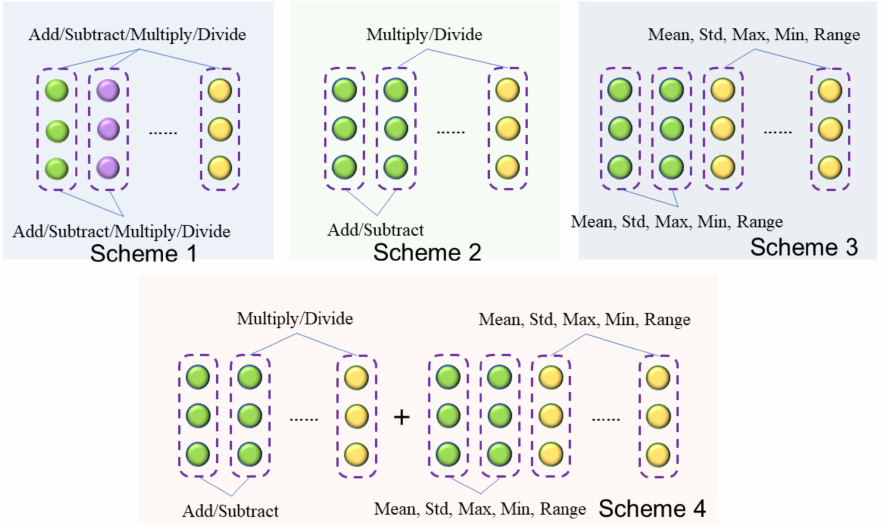
Figure 2. Feature crossing